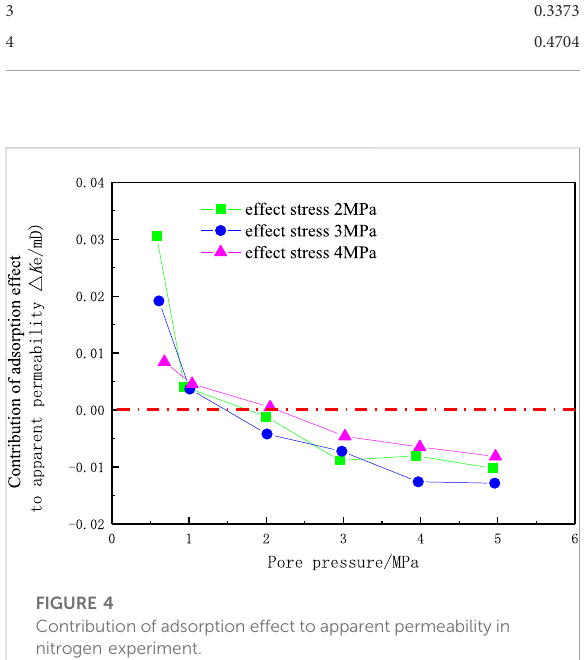
FIGURE 4 Contribution of adsorption effect to apparent permeability in nitrogen